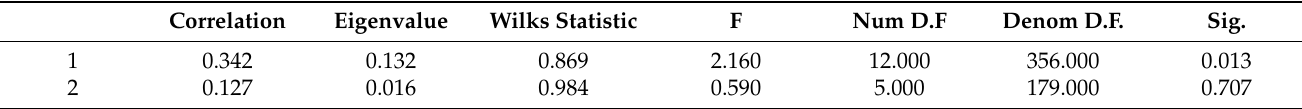
Figure 5. Canonical correlation between joint noise at different frequency components combined with air concentration, registered hypertension cases, and hypertension rate. Table 5. Canonical correlation and Eigen